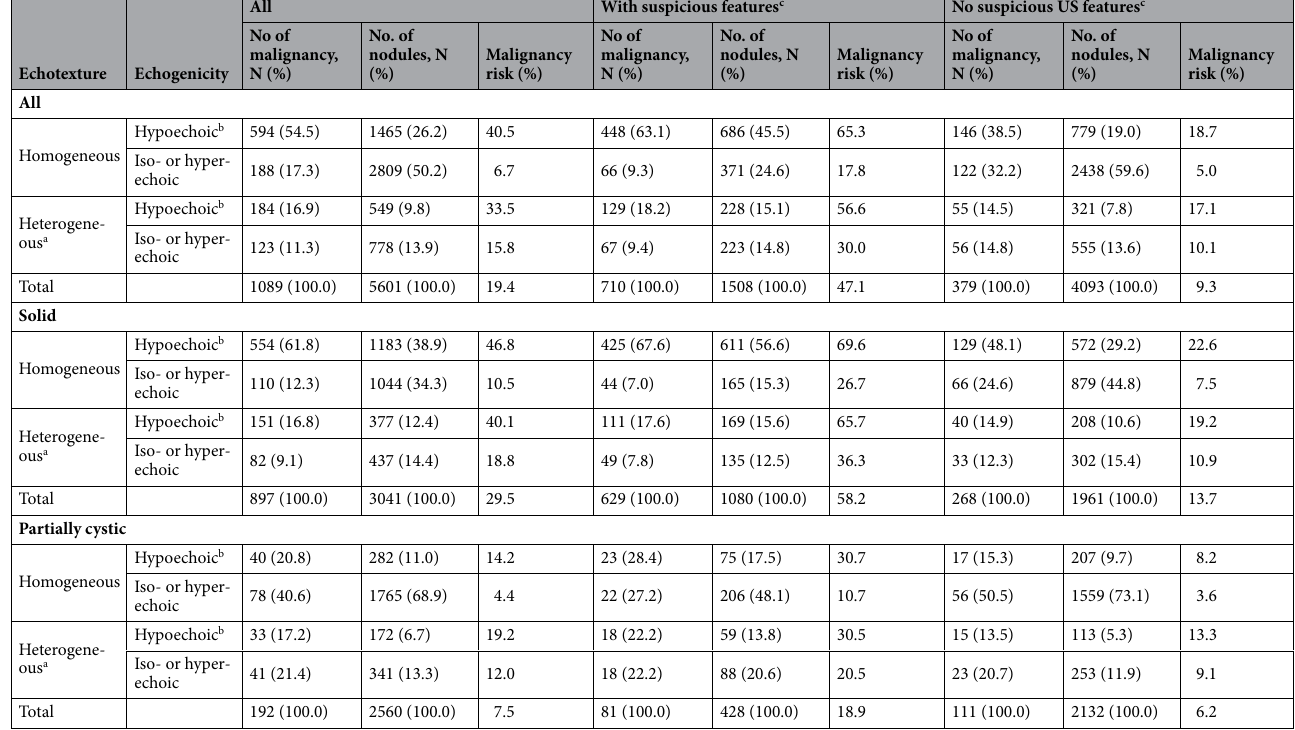
Table 2. Malignancy risk stratified by echogenicity and echotexture. a Nodule echogenicity was categorized by the predominant echogenicity in nodules with heterogeneous echotexture. b Hypoechogenicity includes any of marked-, moderate-, and mild hypoechogenicity. c Suspicious US features include punctuate echogenic foci, nonparallel orientation (taller than wide) and irregular